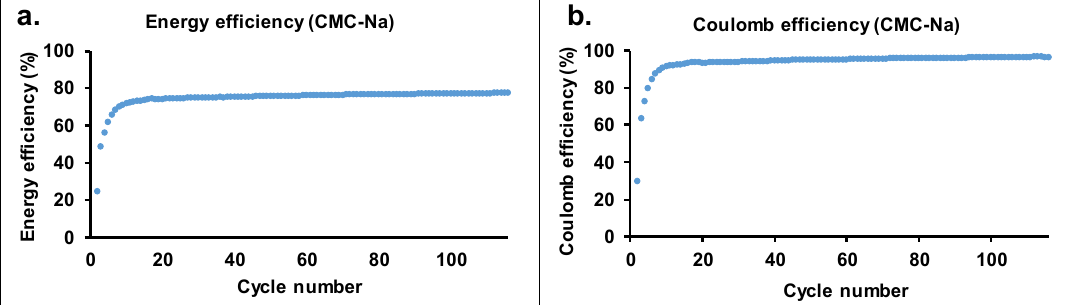
Figure 5. The energy ( a ) and Coulomb efficiency ( b ) of the Zn-air battery equipped with brass anode with 2 m/v% CMC-Na salt additive, aqueous KOH (6 M), and ZnO (0.25 M).